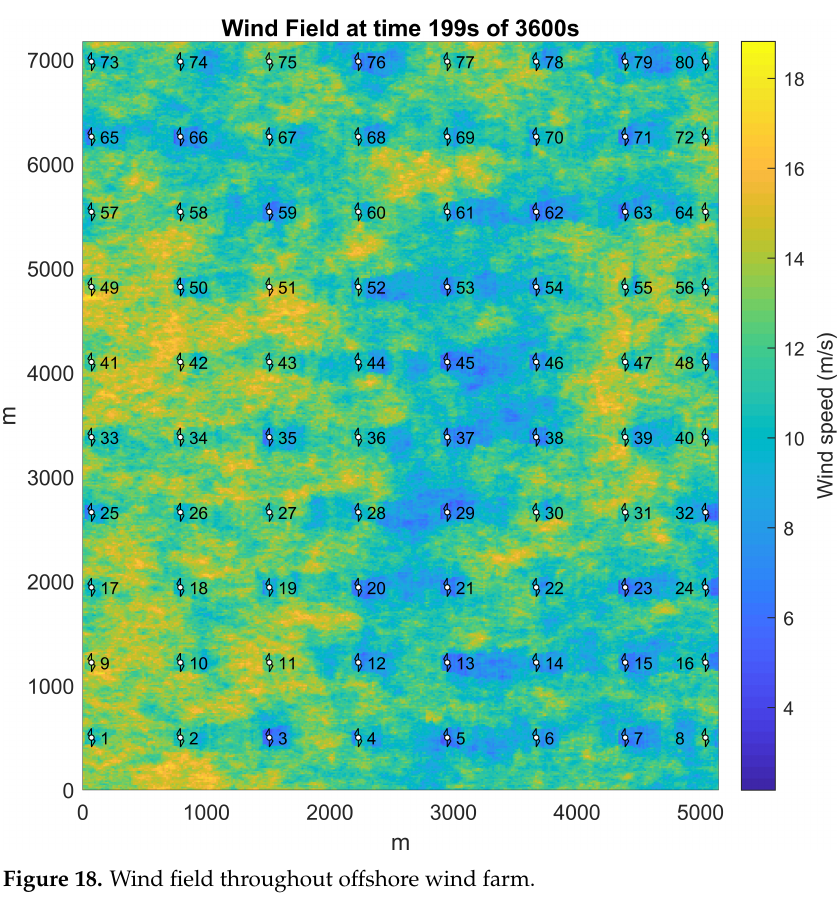
Figure 18. Wind field throughout offshore wind farm.